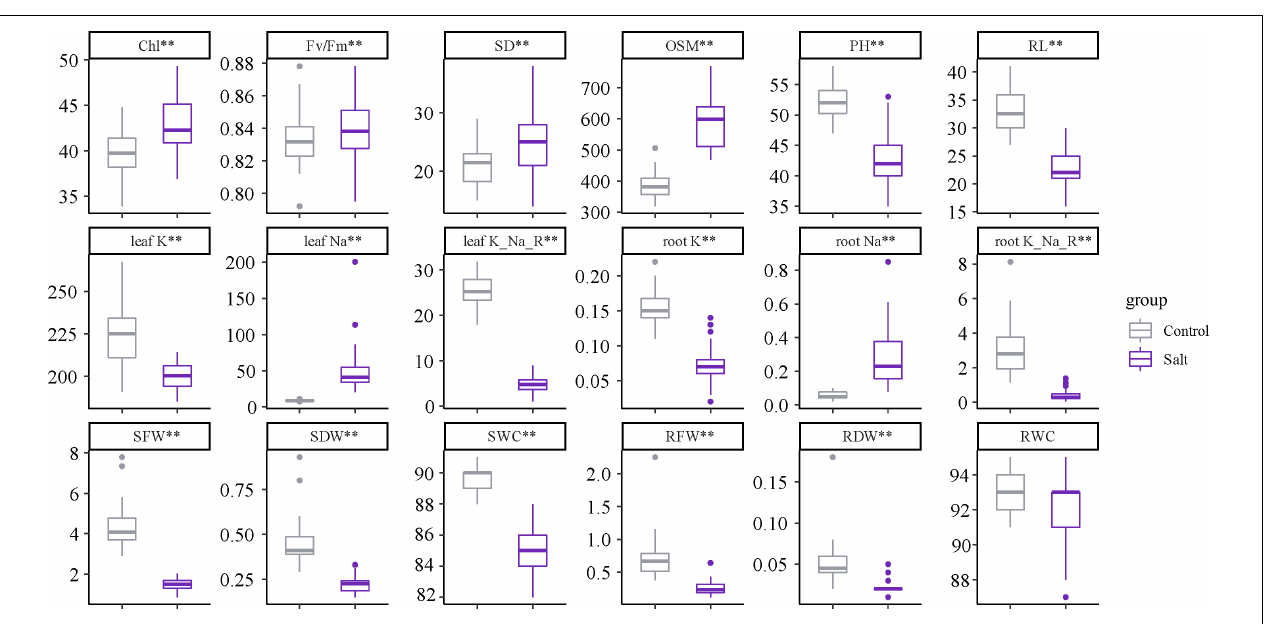
FIGURE 2 | Trait performance under normal and salt treatments. Asterisks (**) indicate that the trait mean was significantly different ( p -value < 0.01) between the salt and control